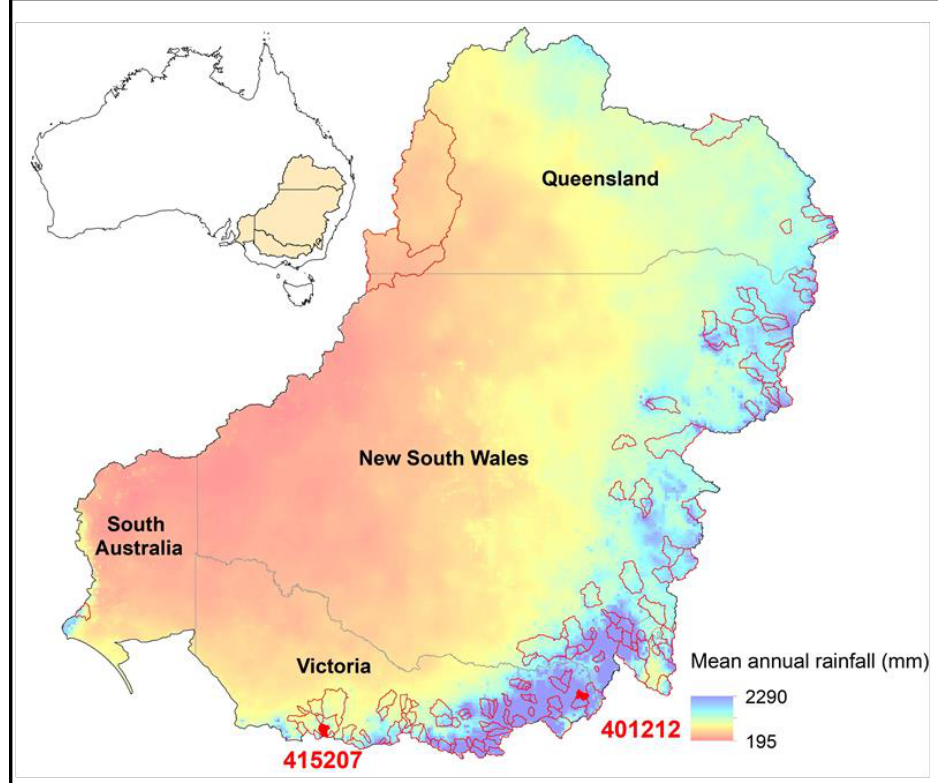
Figure 2. Locations of 133 catchments used for the modelling (detailed results are presented for the two red catchments).